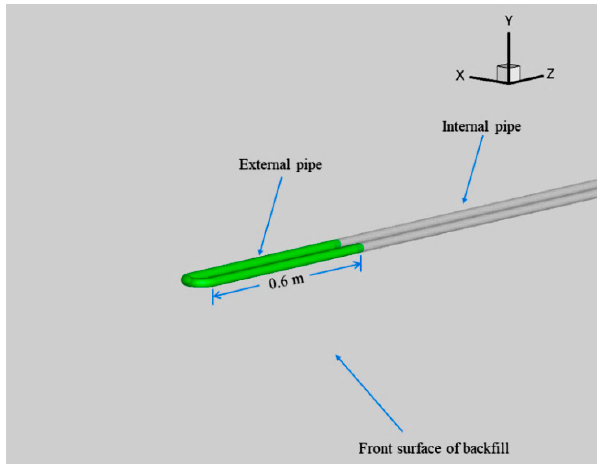
Figure 3. The external U ‐ bend